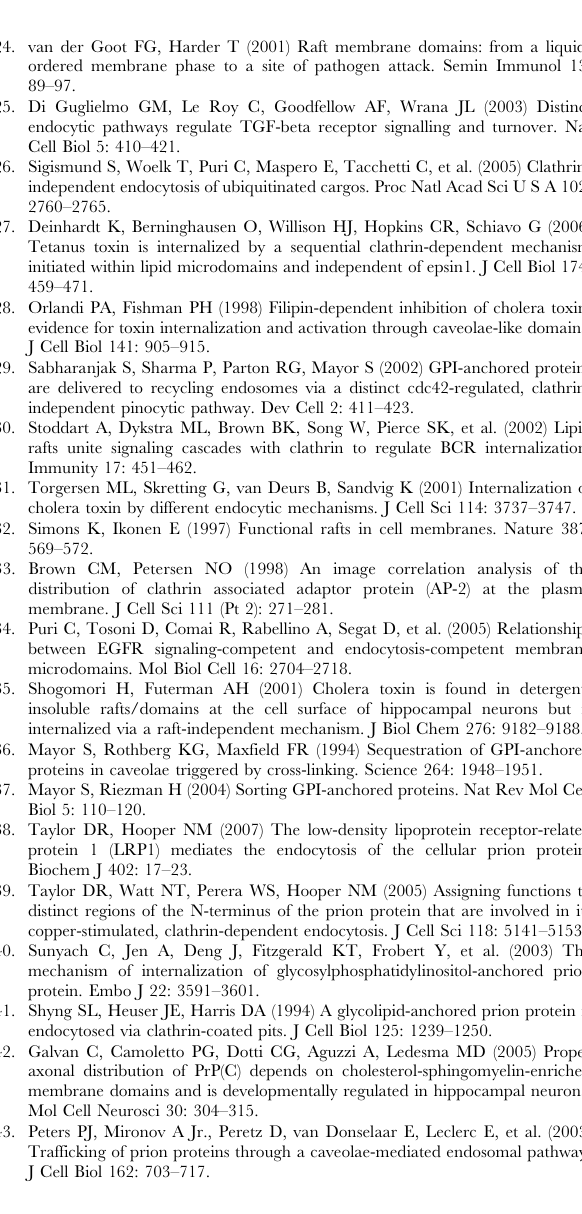
Figure S5 Analysis of Ag35/40 localization and measurement of transepithelial resistance after cholesterol depletion and hypertonic treatment. A) FRT-PrP C cells were grown on transwell permeable filter supports (Costar), in control or cholesterol depleted conditions and incubated for 30 min at 37 u C in control or high sucrose medium. Cells where then stained for the basolateral marker Ag35/40 adding a specific antibody either to the apical or basolateral side of the filters. Samples were analyzed with a Zeiss Laser Scanning Confocal Microscope (LSM 510) equipped with a planapo 63 6 oil-immersion (NA 1.4) objective lens. Bar: 10 m m. B) Transepithelial resistance (TER) was measured for 7 days after plating 2 6 10 6 cells on 24 mm diameter transwell filters in control or cholesterol depletion conditions. After 4 days of culture, only cholesterol depleted cells were incubated for 30 min at 37 u C in high sucrose medium and TER was measured by the Millicellers apparatus (Millipore). Note that we process the cells at 4 days of culture, when the TER is maximal and that the combined treatment does not affect the monolayer integrity at this